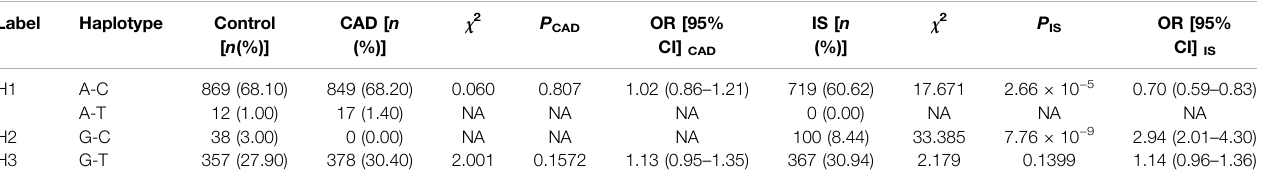
TABLE 5 | Associations between haplotype frequencies of the two EHBP1 SNPs and CAD or IS [ n (frequency)]. Label